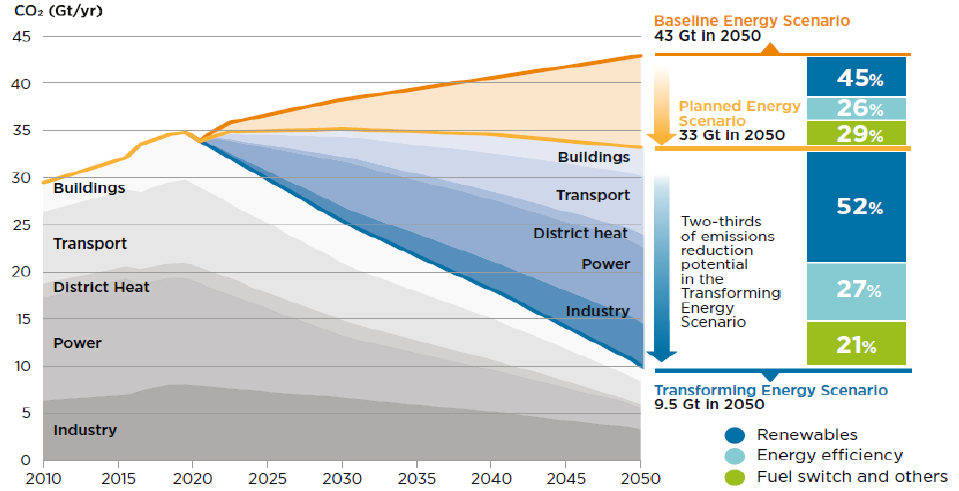
Figure 2. Yearly CO 2 emissions from diverse sectors of energy by 2050 [8].